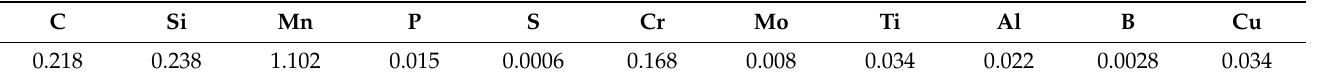
Table 1. Chemical composition of the experimental steel (mass %).